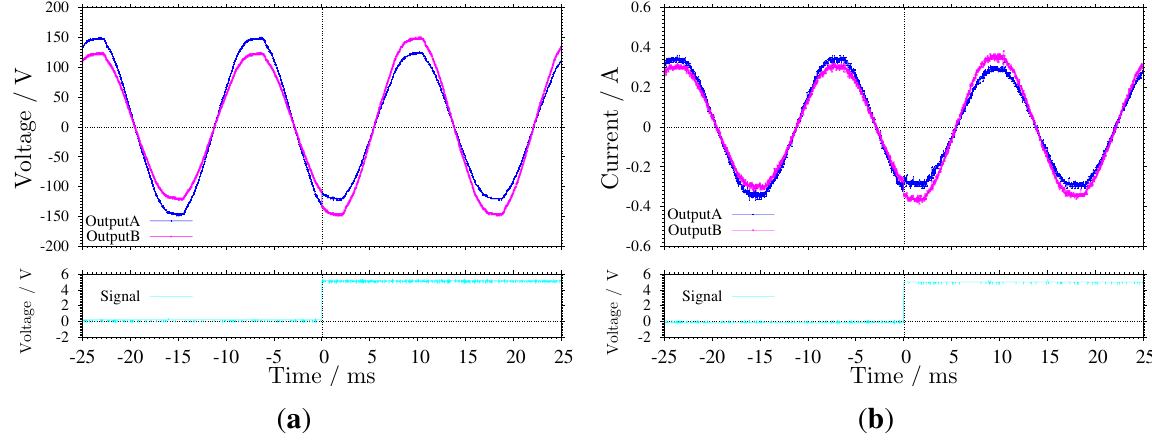
Figure 4. Output waveforms of circuit switching operation with no phase difference between two inputs: ( a ) output voltage waveforms; and ( b ) output current waveforms.